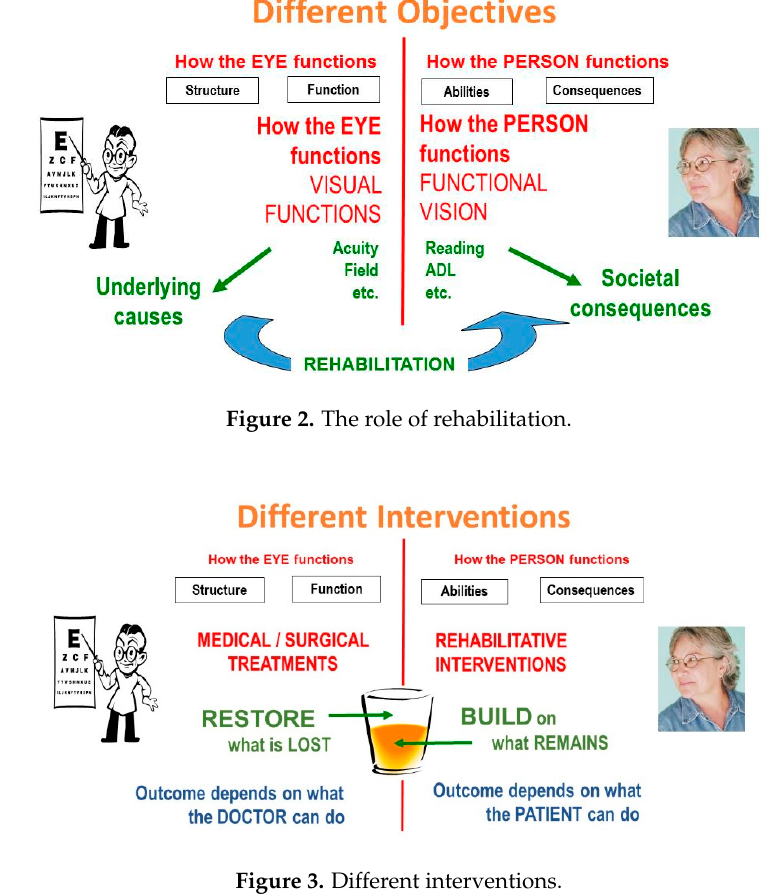
Figure 3. Different interventions.